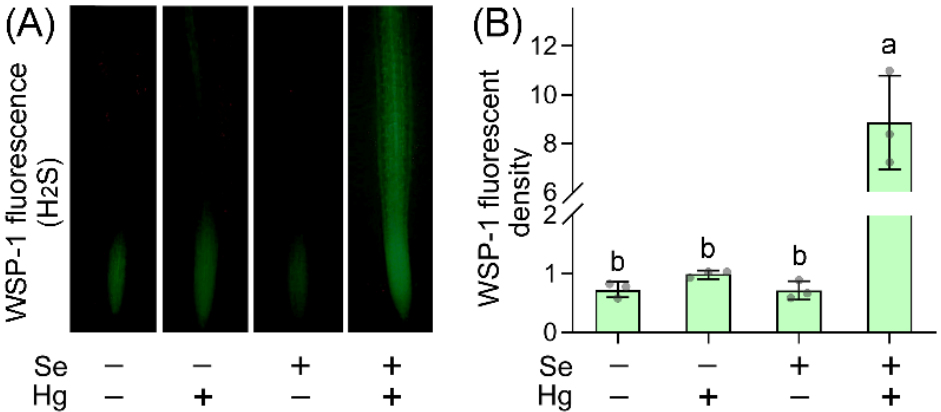
Figure 2. Hg + Se enhanced endogenous H 2 S level in the root tip of B. rapa seedlings. ( A ) Endogenous H 2 S in root tip was indicated by WSP-1 fluorescence. ( B ) Calculated relative WSP-1 fluorescent density in root tips. Different lowercase letters indicated significant difference among different treat- ments (ANOVA; n = 3; p < 0.05).